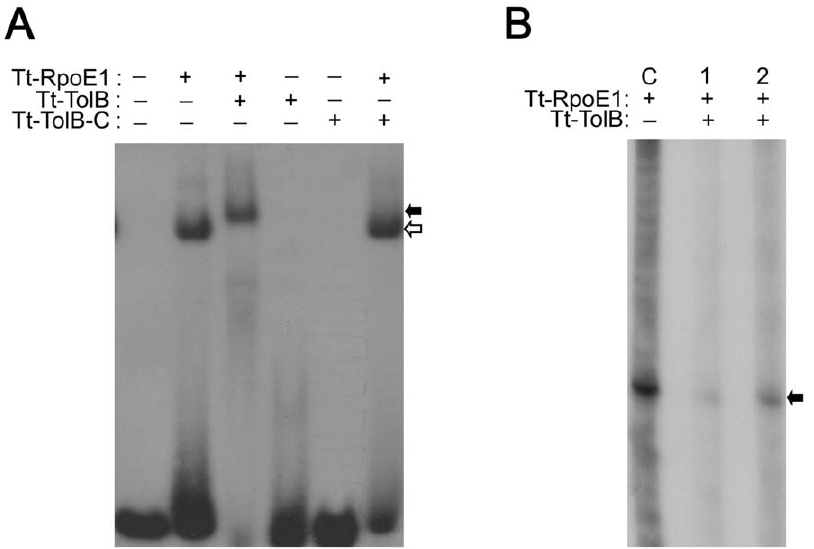
Figure 4. The effect of putative anti- s factor Tt-TolB on the activity of Tt-RpoE1. ( A ). The effect of Tt-TolB on the interaction between Tt- RpoE1 and fork-junction structure promoter DNA (T + 1/B 2 10). The indicated proteins were added ( + ) in an EMSA reaction at a concentration of 5 m M. The solid arrow indicates the supershifted complex formed by Tt-RpoE1, Tt-TolB, and the promoter, and the open arrow indicates the complex formed by Tt-RpoE1 and the promoter. ( B ). The effect of Tt-TolB on in vitro transcription of Tt-RpoE1. Lane 1. Tt-TolB was added into the transcription system at the same time with Tt-RpoE1. Lane 2. Tt-TolB was added into the transcription system after Tt-RpoE1, E.coli core RNAP and promoter DNA being incubated (see materials and methods). Lane C, the in vitro transcription system without Tt-TolB. The solid arrow indicates the products of transcription.